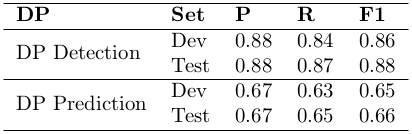
Table from the paper: A Novel Approach to Dropped Pronoun Translation
Table text:
DP
Set
P
R
F1
DPDetection
Dev
0.88
0.84
0.86
Test
0.88
0.87
0.88
DPPrediction
Dev
0.67
0.63
0.65
Test
0.67
0.65
0.666